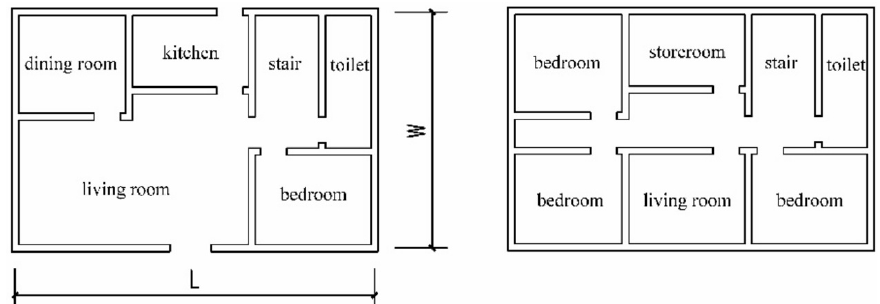
Figure 3. Floor plan of a typical rural